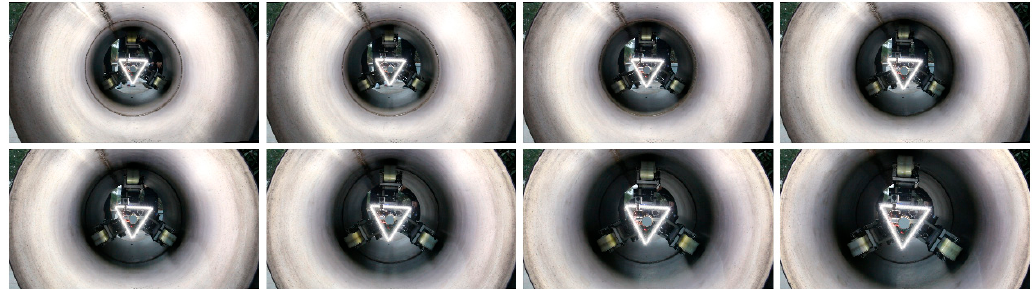
Figure 19. Di ff erential speed driving experiment (every 3 Figure 19. Differential speed driving experiment (every 3 s). Figure 19. Differential speed driving experiment (every 3 s). Figure 19. Differential speed driving experiment (every 3 s).